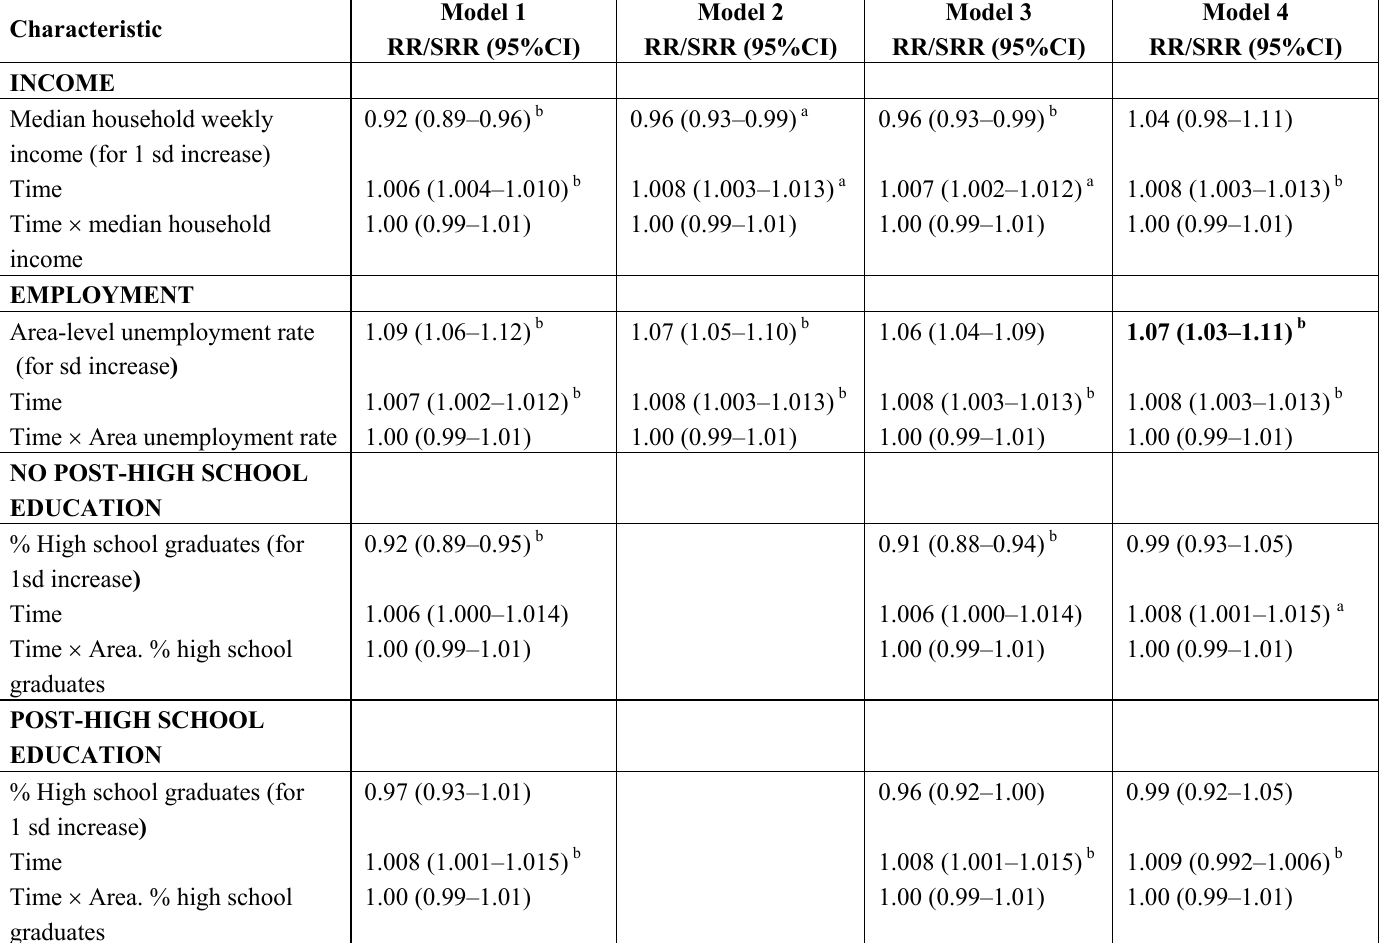
Table 4. Associations between area-level SEP and baseline prevalence and trajectory of MetS component